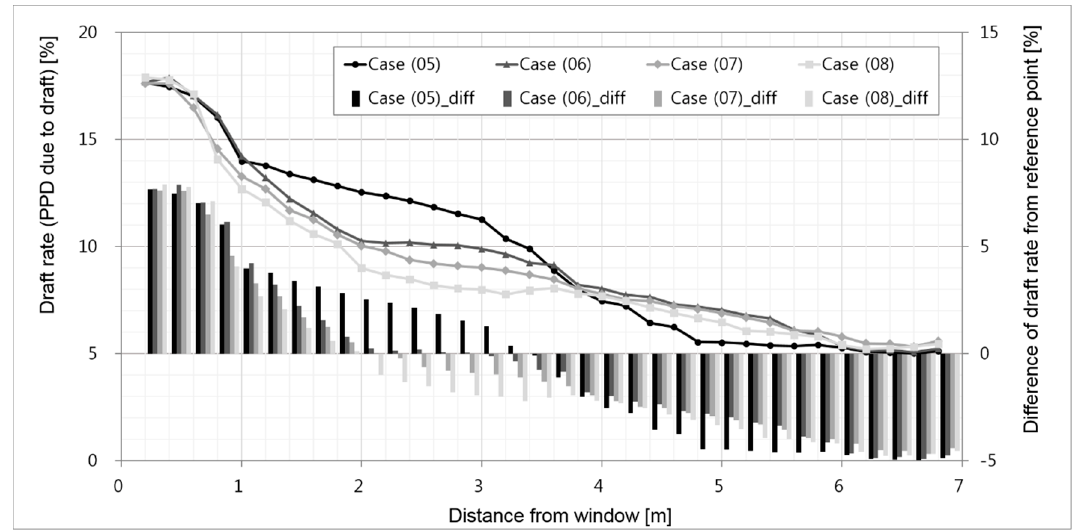
Figure 14. Draft rate by distance from window (window U -value is 1.75 W/m 2 ·K).